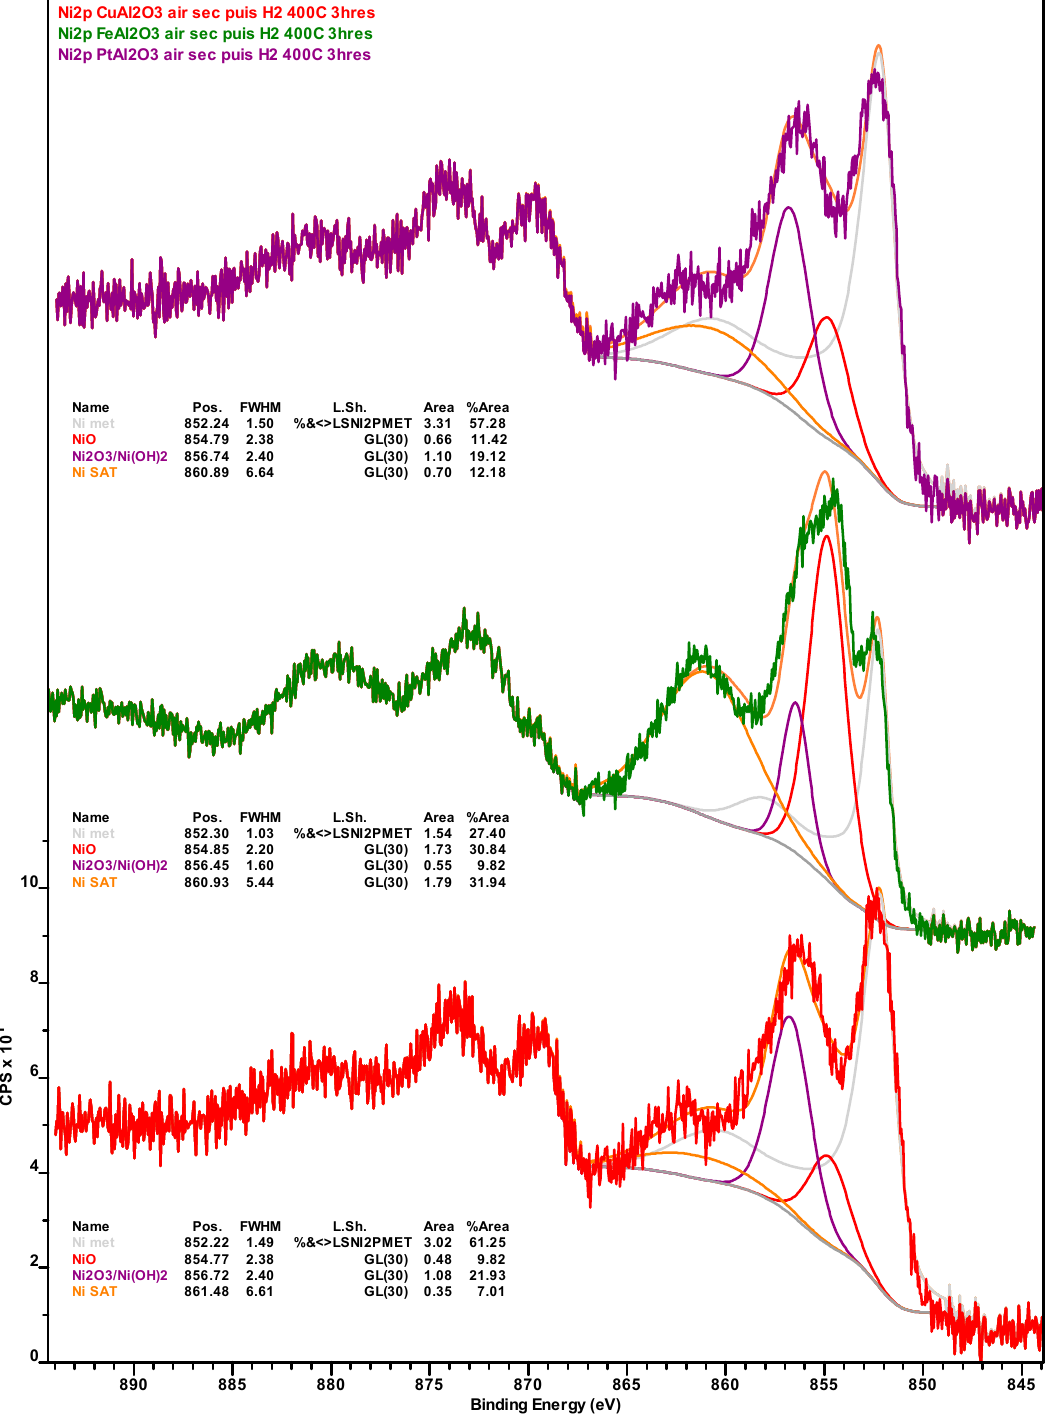
Figure A3. Nickel 2p X-ray photoelectron spectra of the spent Ni-Cu (red spectrum), Ni-Fe (green spectrum) and Ni-Pt (purple spectrum) catalysts recovered from deoxygenation experiments after calcination in air at 450 °C for 5 h and reduction under H 2 at 400 °C for 3 h.